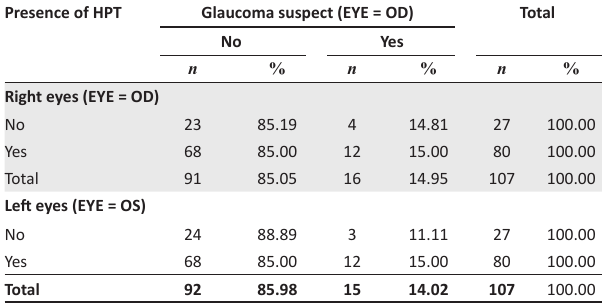
TABLE 4: Hypertension and glaucoma suspect per